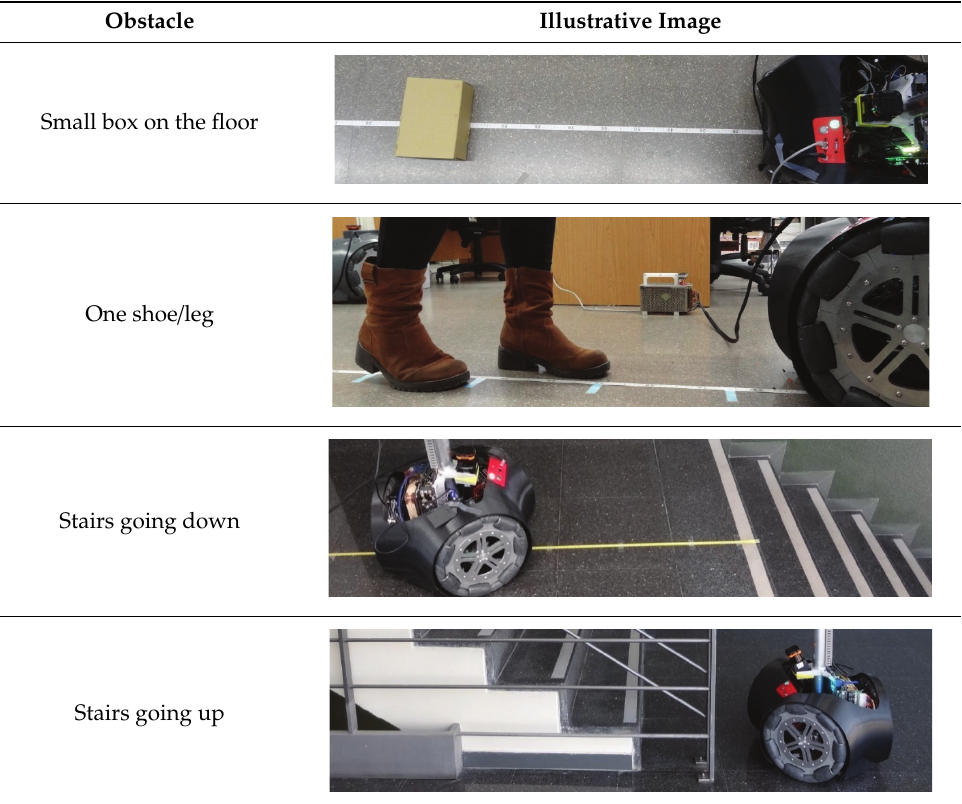
Table 1. Illustrative images of the validation detection experiments: small box, one shoe/leg, stair going down, and stairs going up.